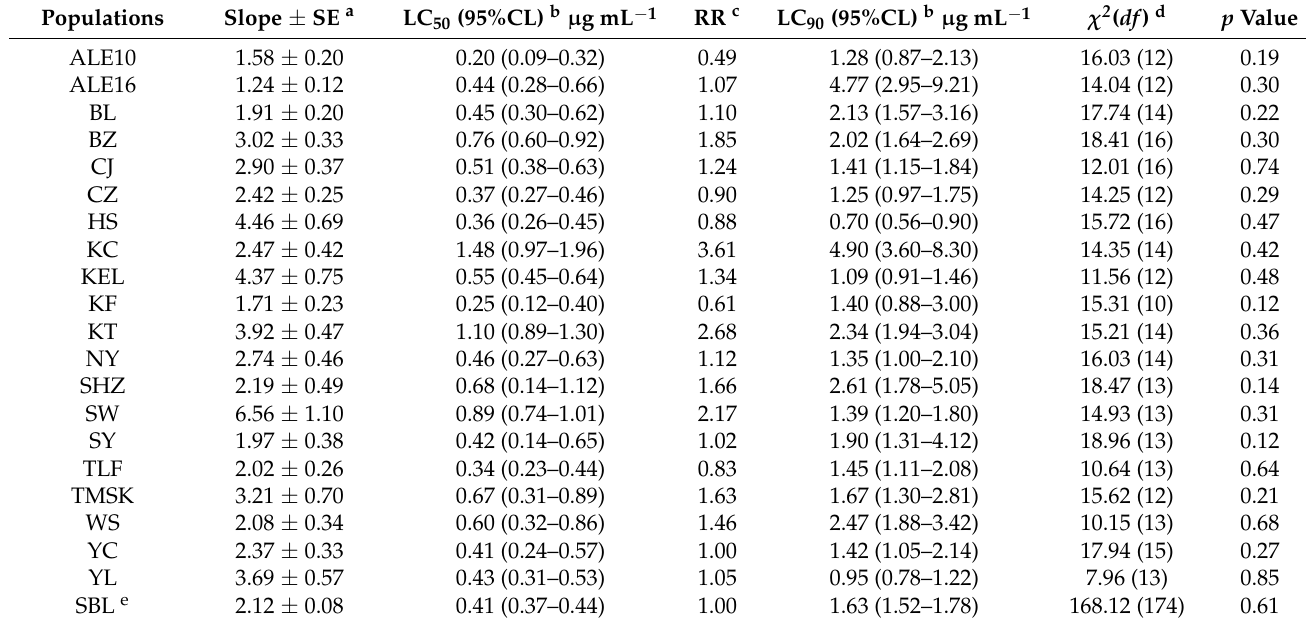
Table 2. Toxicity of broflanilide to Aphis gossypii field populations.